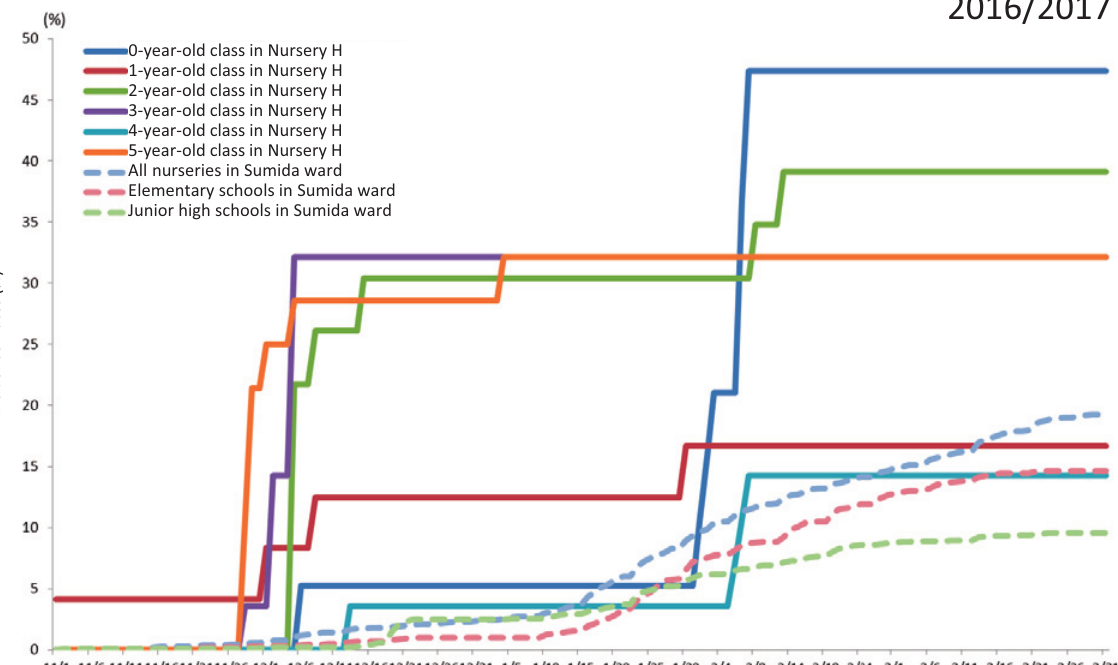
F i g . 5 D y namics of incidence rates of infl u enza b y a g e in N u rser y H compared w ith all n u rseries, and all elementar y and j u nior hi g h schools in S u mida W ard in the 2016/2017